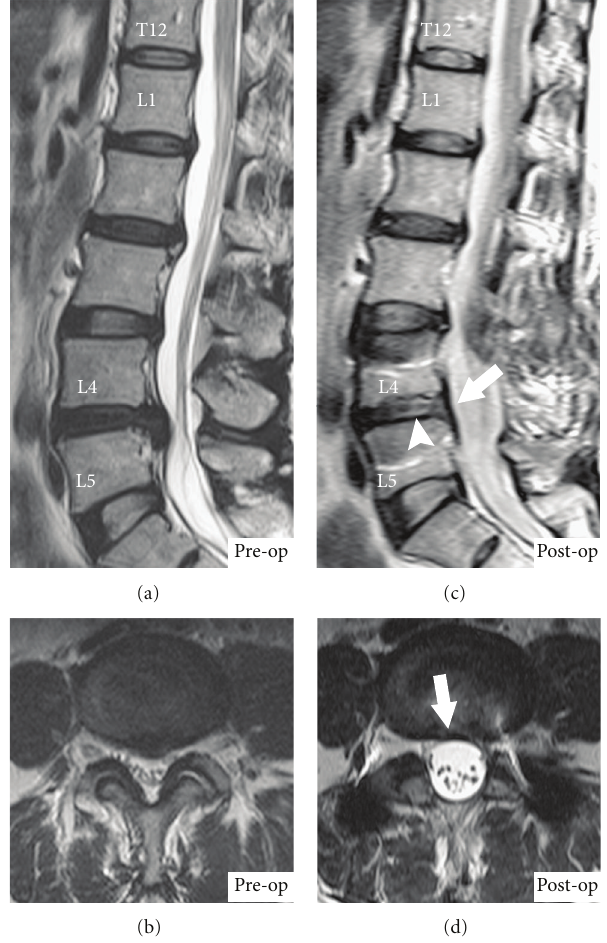
Figure 3: MRI T2-weighted image of a 56-year-old female. ((a) and (c)) Sagittal view. ((b) and (d)) Axial view. The significant increase in CDS was seen in L4-5 level (preoperative 0.44 to postoperative 0.92) at 24-month followup. Meanwhile, the signal intensity of T12-L1 demonstrated to be similar brightness. Arrow, reduced bulging disc after stabilization; arrowhead, significant increase in CDS.